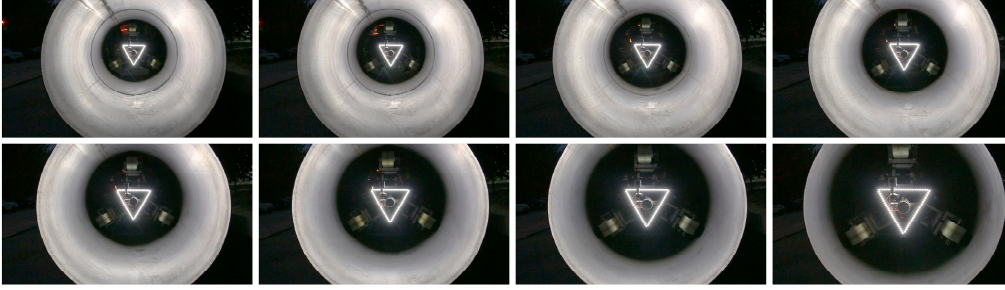
Figure 17. Straight driving experiment (every 3 s).